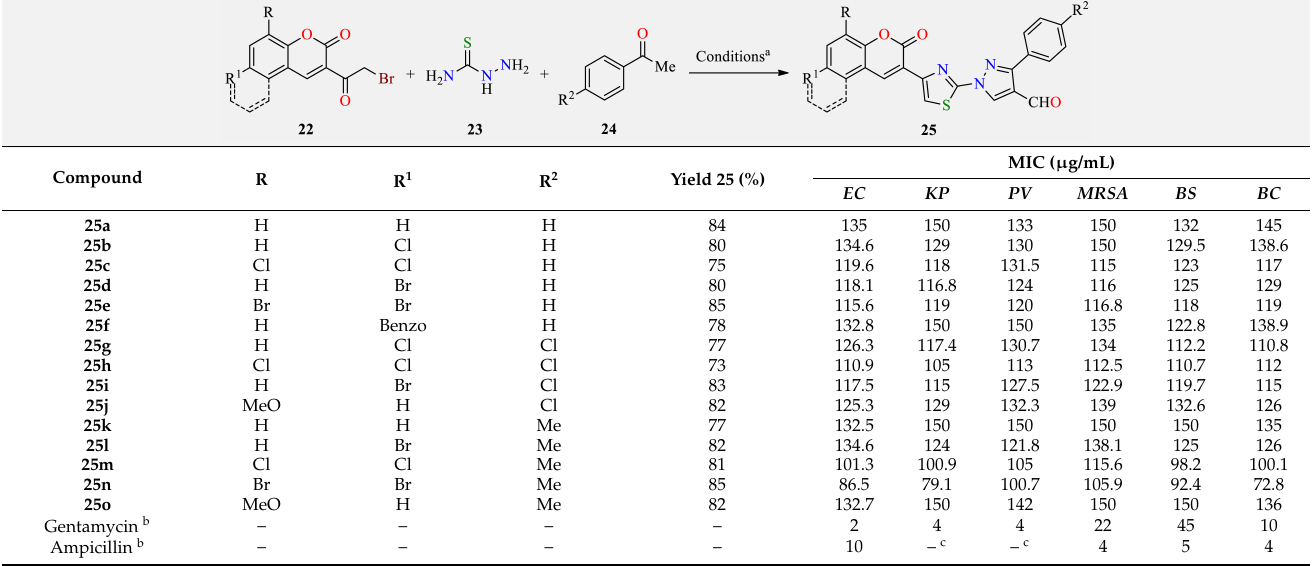
Table 5. One-pot three-component synthesis and antibacterial activity of coumarin